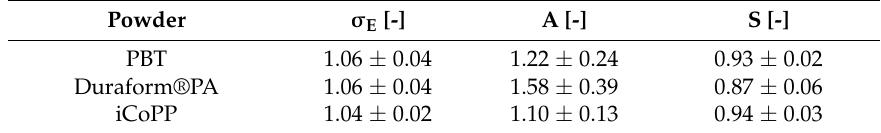
Table 4. Particle shape descriptors for the PBT powder and commercially used reference powders.